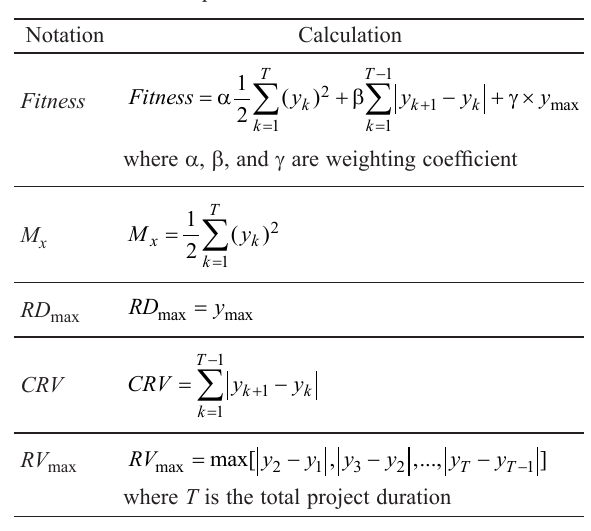
Table 1. Metrics for performance measurement